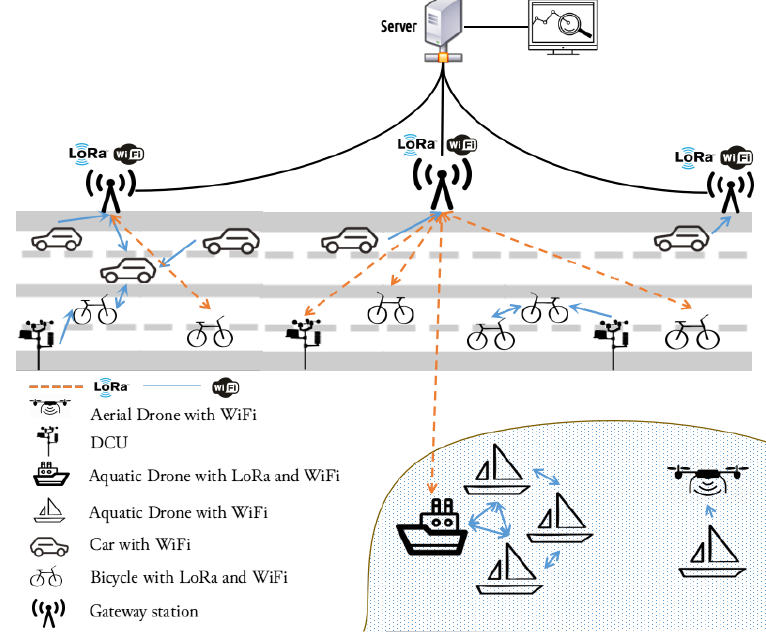
Figure 1. Architecture